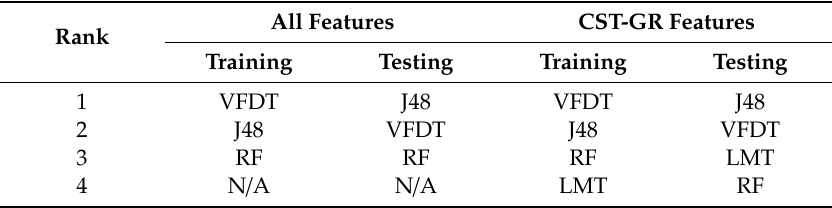
Table 5. Ranking of response